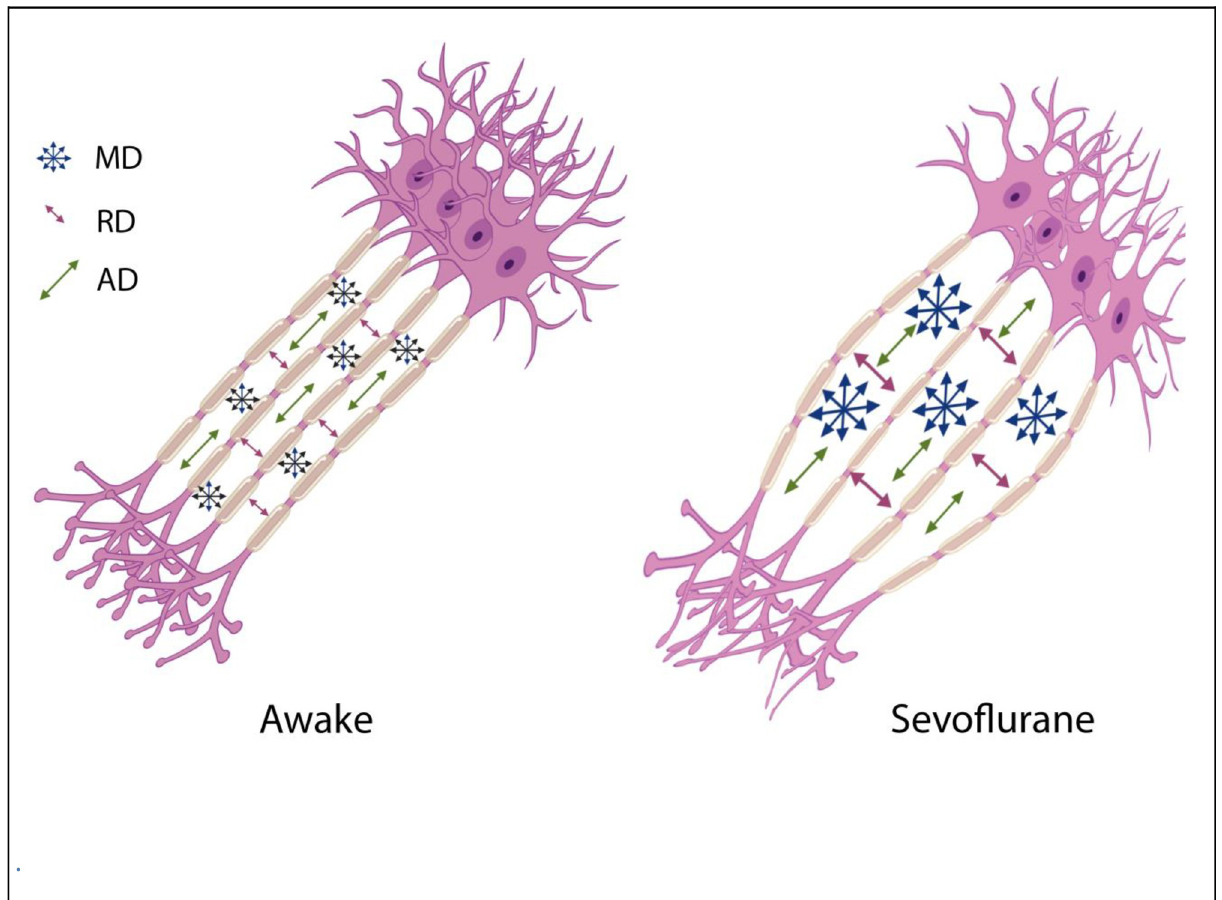
Fig 4. Illustration of one possible geometric implication of the DTI metrics. Increases in the interaxonal space will result in increased MD and RD, but to a lesser extend the AD.